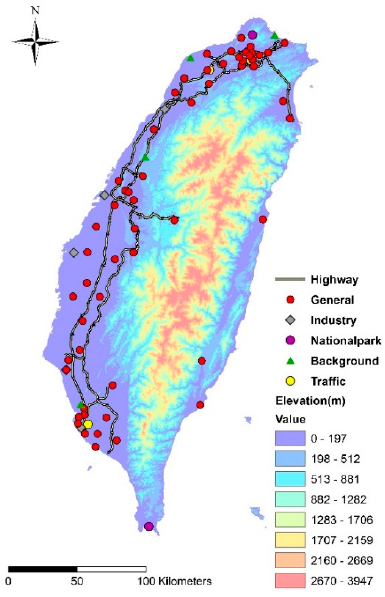
Figure 1. Annual average O 3 levels at six types of monitoring stations over the study years.